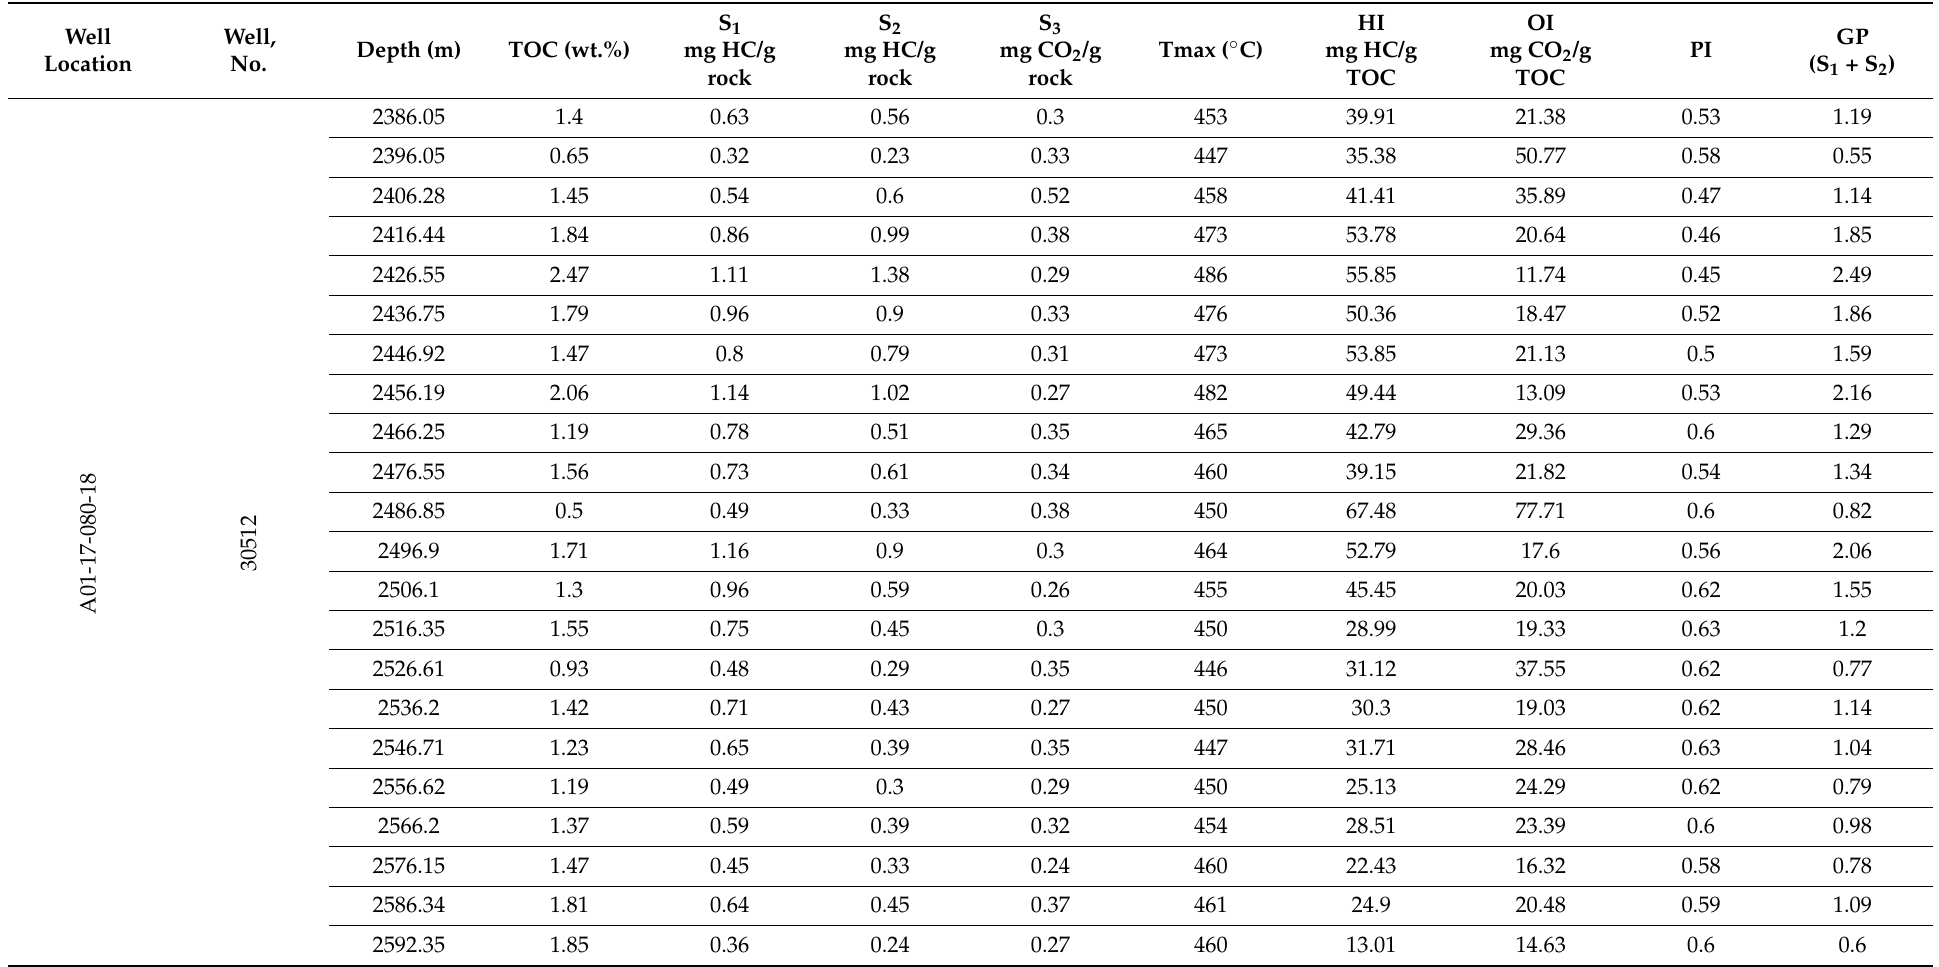
Table 1. SRA data set shows the different pyrolysis parameters for 58 core samples from 4 Montney Formation